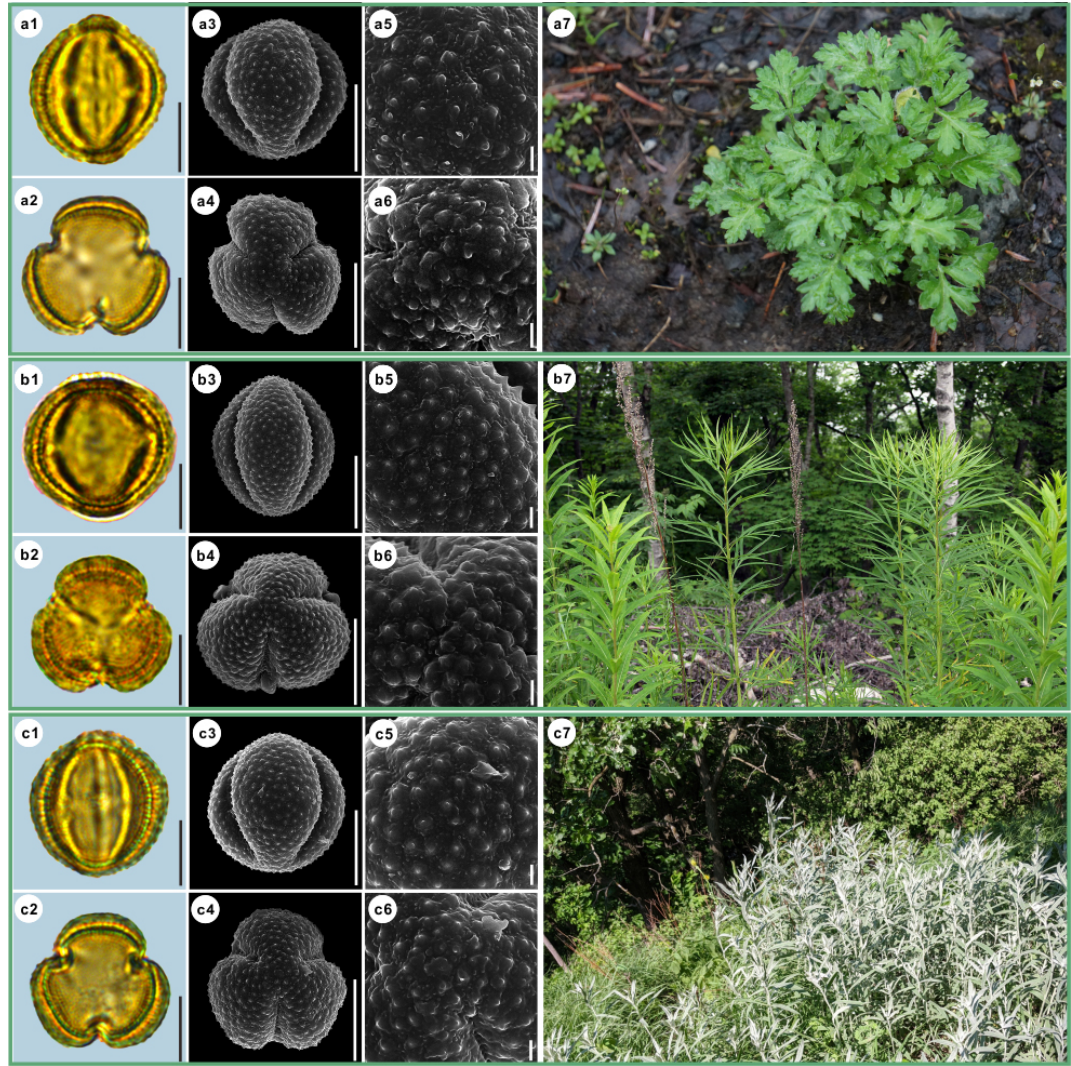
Figure 5. Pollen grains and the habitats of their source plants. (a) Artemisia vulgaris ; (b) Artemisia selengensis ; and (c) Artemisia ludovi- ciana . Pollen grains in equatorial view under LM (a1, b1, c1) and SEM (a3, a5, b3, b5, c3, c5) , in polar view under LM (a2, b2, c2) and SEM (a4, a6, b4, b6, c4, c6) , along with the habitats of their source plants (a7 cited from https://www.inaturalist.org/photos/120600448, last access: 19 August 2022, by © Sara Rall, b7 cited from https://www.inaturalist.org/photos/46352423, last access: 19 August 2022, by © Gularjanz Grigoryi Mihajlovich, c7 cited from https://www.inaturalist.org/photos/77690333, last access: 19 August 2022, by © Ethan Rose ) . Scale bar in LM and SEM overview 10µm, and in SEM close-up